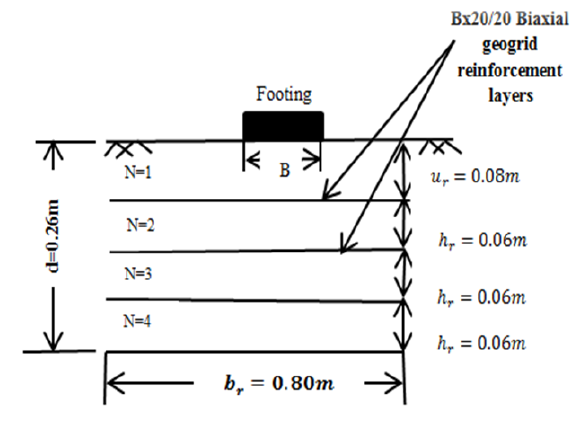
Figure 4(a): Cross-section of adopted criteria for placement of geogrid. Fig. 4 (a) Cross-section of adopted criteria for placement of geogrid